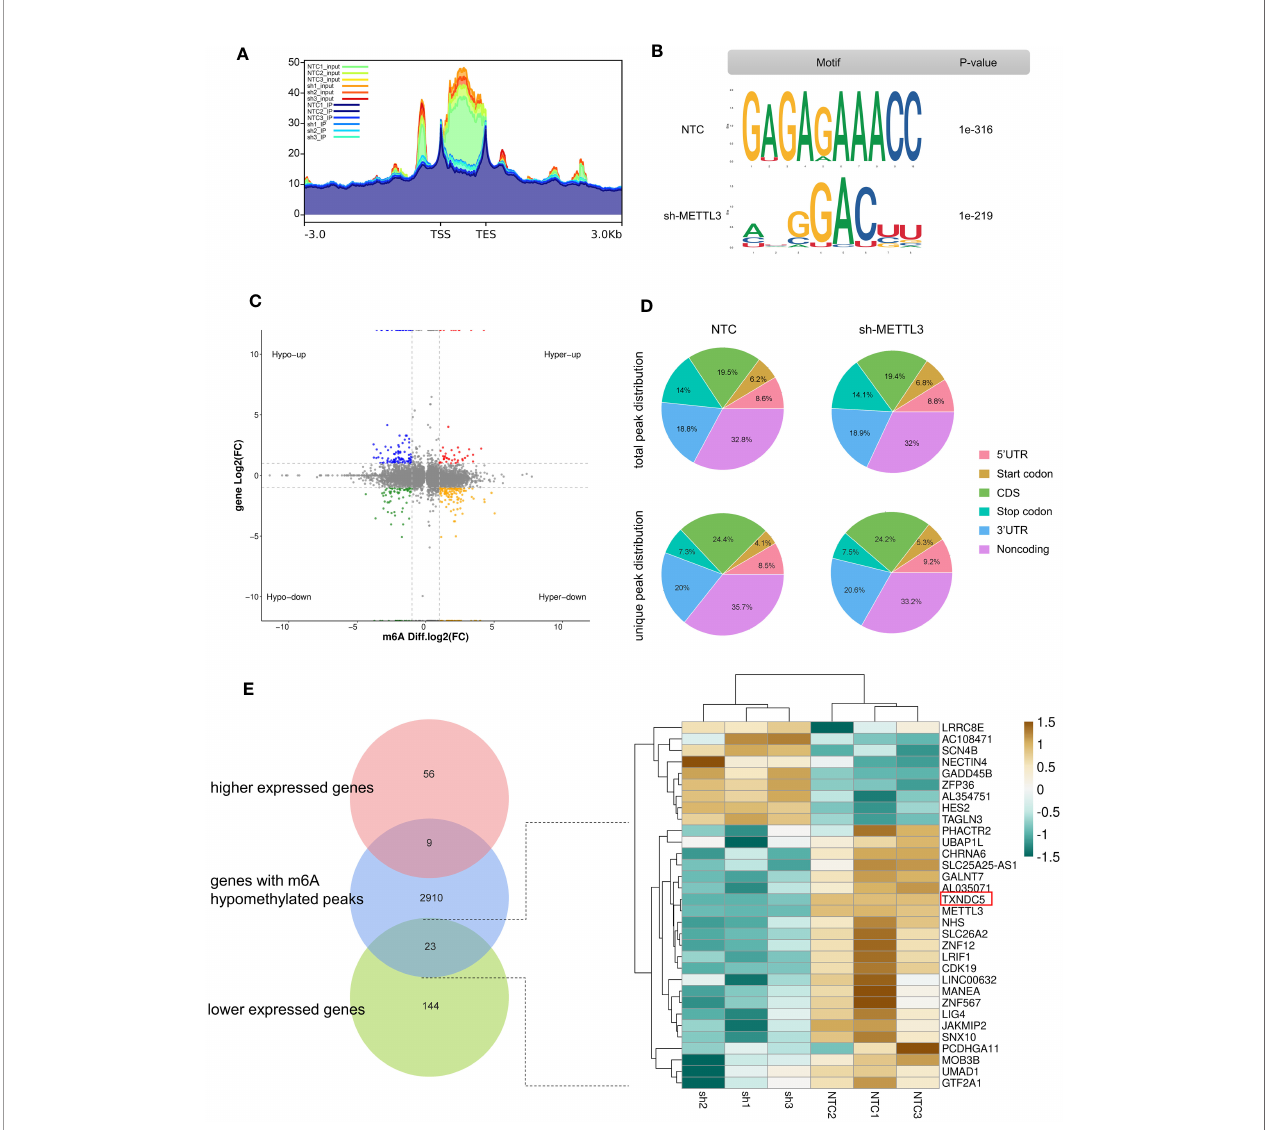
FIGURE 6 | Effects of METTL3 are mediated via m 6 A methylation. (A) Metagene analysis showing different m 6 A peak distribution between NTC and METTL3 knockdown groups. (B) “ RRACH ” as the consensus motif identi fi ed by HOMER with m 6 A peaks in A375 cells with or without METTL3 knockdown. (C) Distribution of genes showing signi fi cant changes in both m 6 A level (log2 fold-change) and gene expression level (log2 fold-change, p < 0.05) in NTCs and sh-METTL3 A375 cells. (D) Proportion of m 6 A peak distribution in 5 ′ -UTR, start codon, noncoding, coding sequence, stop codon, and 3 ′ -UTR regions in the entire set of RNA transcripts; the total and unique m 6 A peaks in both groups are shown. (E) Venn diagram and heatmap illustrating genes as potential targets of METTL3 identi fi ed by MeRIP-seq and